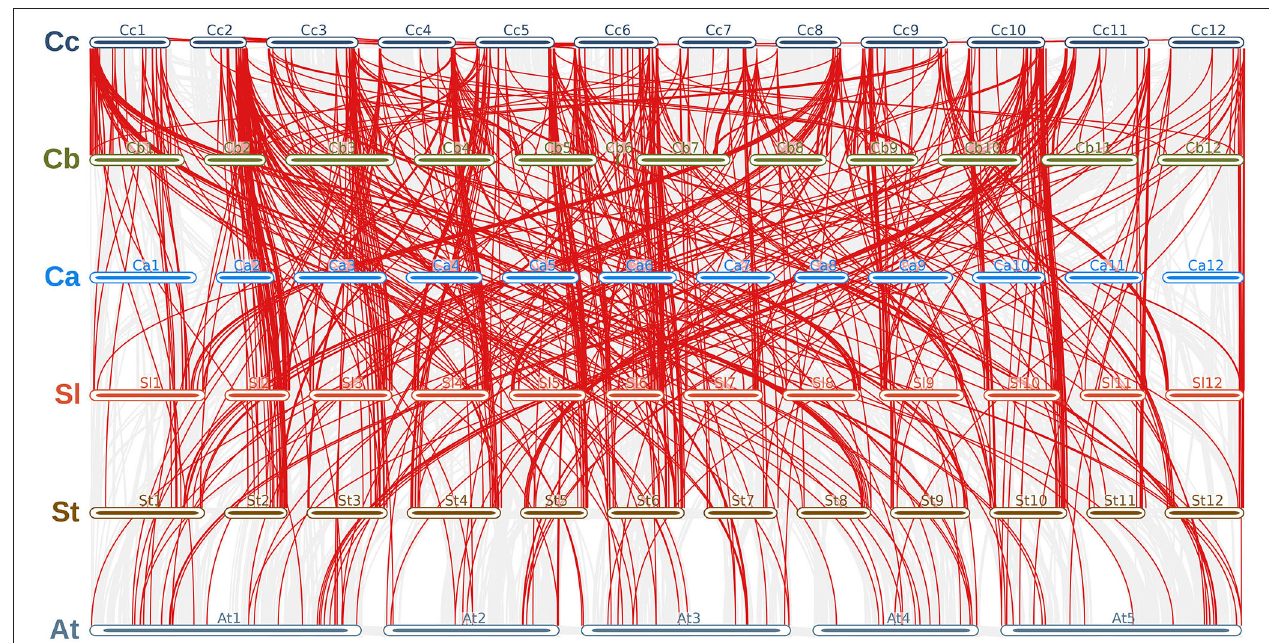
FIGURE 8 | Synteny and collinearity of the C. chinense ( CcMYB ) genes with the Capsicum annuum (Ca) , C. baccatum (Cb) , Solanum lycoperisucum (Sl) , Solanum tuberosum (St) , Solanum melongena (Sm) , and Arabidopsis thaliana (At) genomes. Gray lines in the background show collinear segments, while red lines represent syntenic MYB gene pairs with respect to the C. chinense genome.